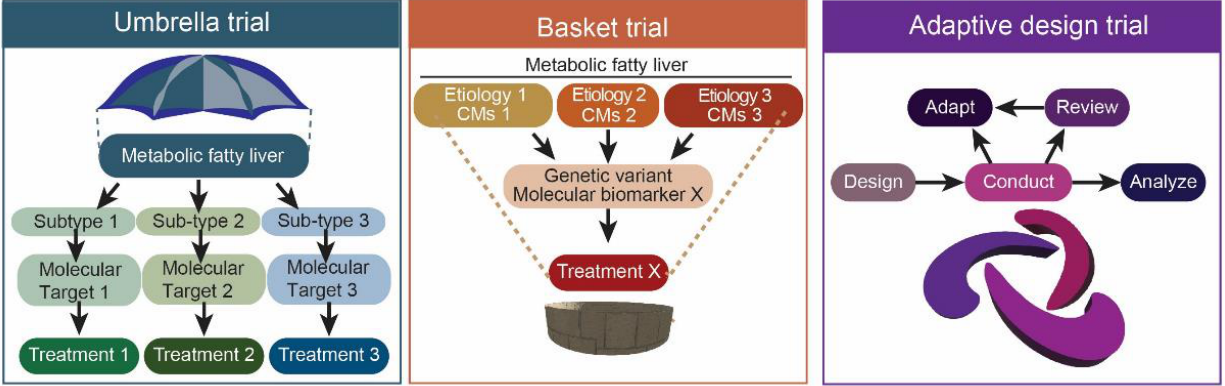
Figure 4. Schematic of Master Protocols application in NAFLD clinical trials. CM—comorbidities. Adapted from [206].